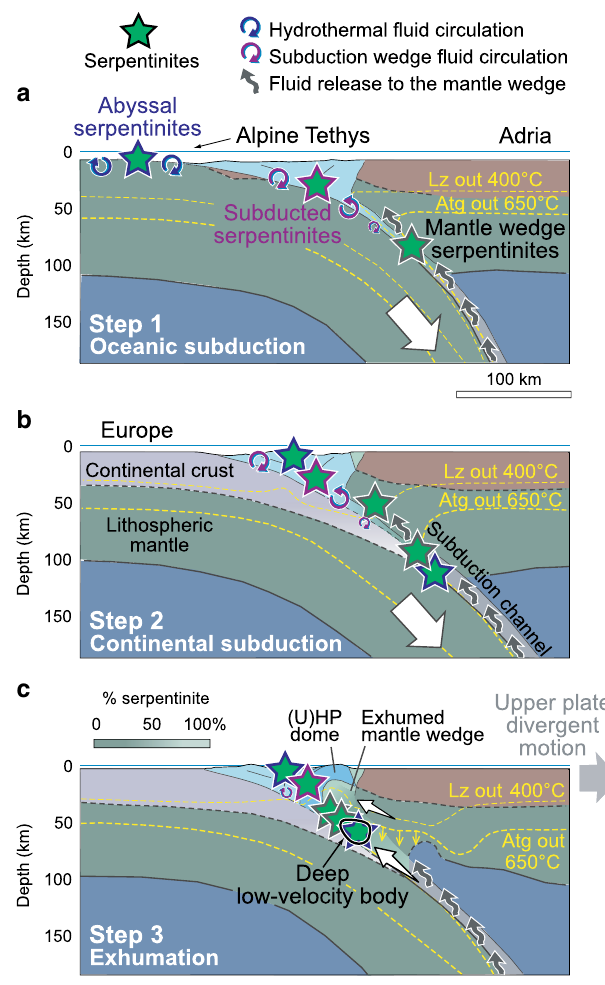
Fig. 4 Environments of serpentinization during subduction and geologic interpretation of the deep – low-velocity body. a Oceanic subduction. b Continental subduction. c Upper-plate divergent motion and exhumation of UHP rocks (crustal features color coded as in Fig. 1b). Lithospheric structure after Zhao et al. 14,15 , Lyu et al. 16 , and Solarino et al. 21 . Environments of serpentinization and fl uid circulation after Deschamps et al. 41 . Evolution of lizardite (Lz) and antigorite (Atg) destabilization isotherms after Liao et al. 46 . Percentage of serpentinite in the exhumed mantle wedge after Solarino et al. 21 . The deep – low-velocity body imaged in the subduction channel consists of abyssal and mantle-wedge serpentinites that lubricate the plate interface and facilitate continental